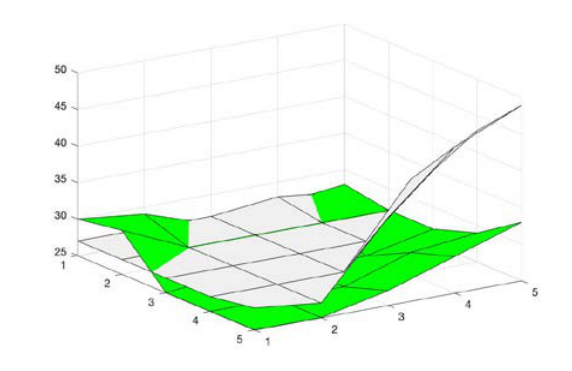
Fig.3. The algorithm of selecting the block